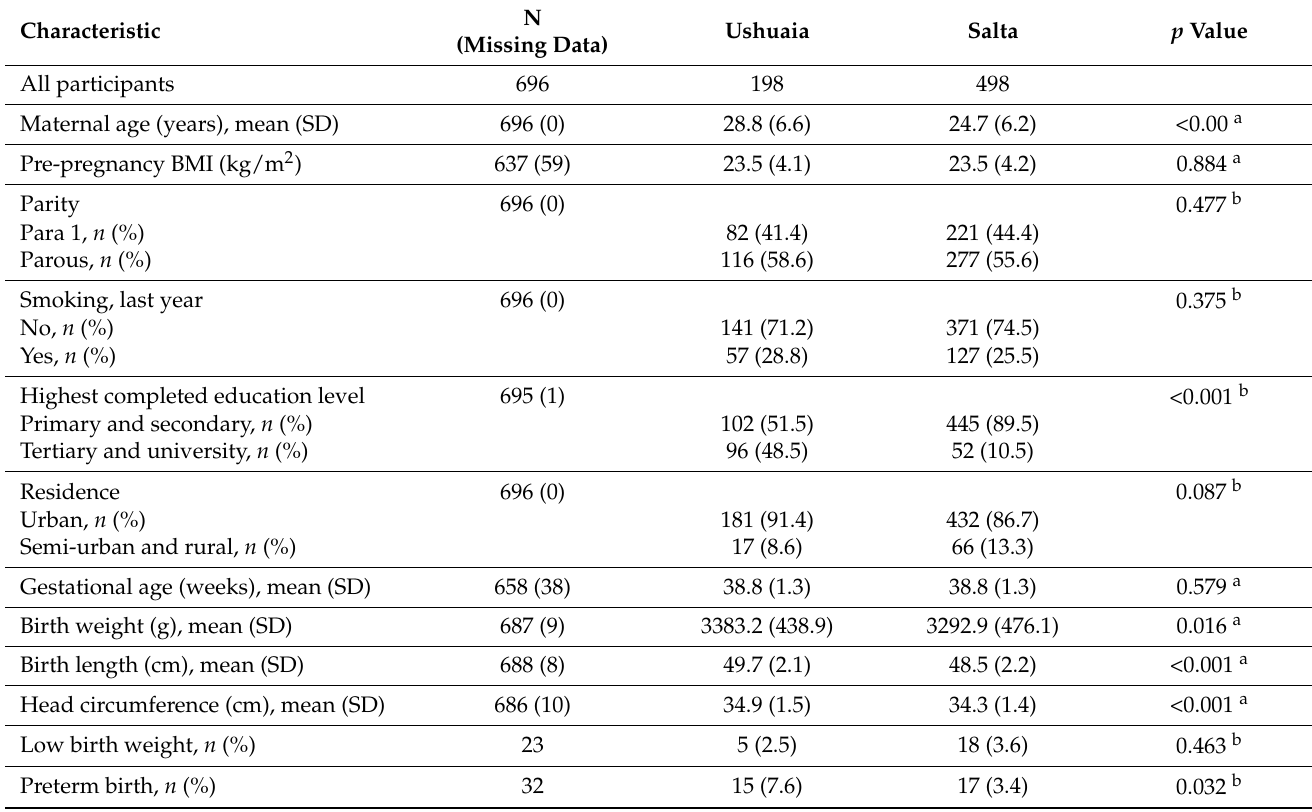
Table 1. Characteristics of studied population in the EMASAR study